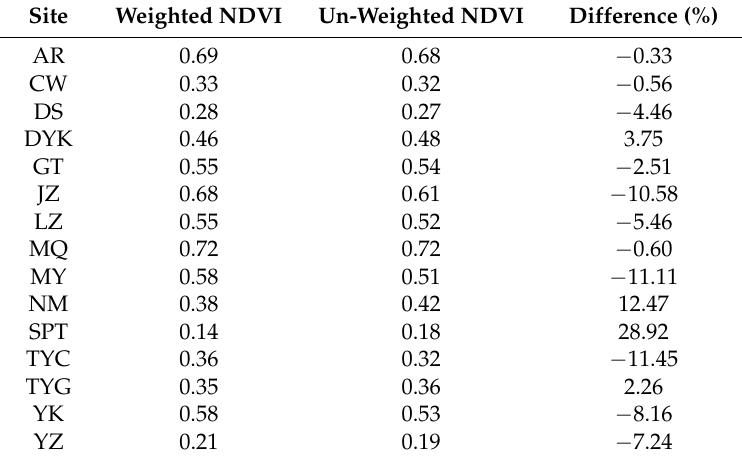
Figure 9. NDVI maps of the 15 sites at a 30 m resolution over grid of 18 km × 18 km centered at individual flux sites. Table 5. Weighted by footprint and un-weighted NDVI.